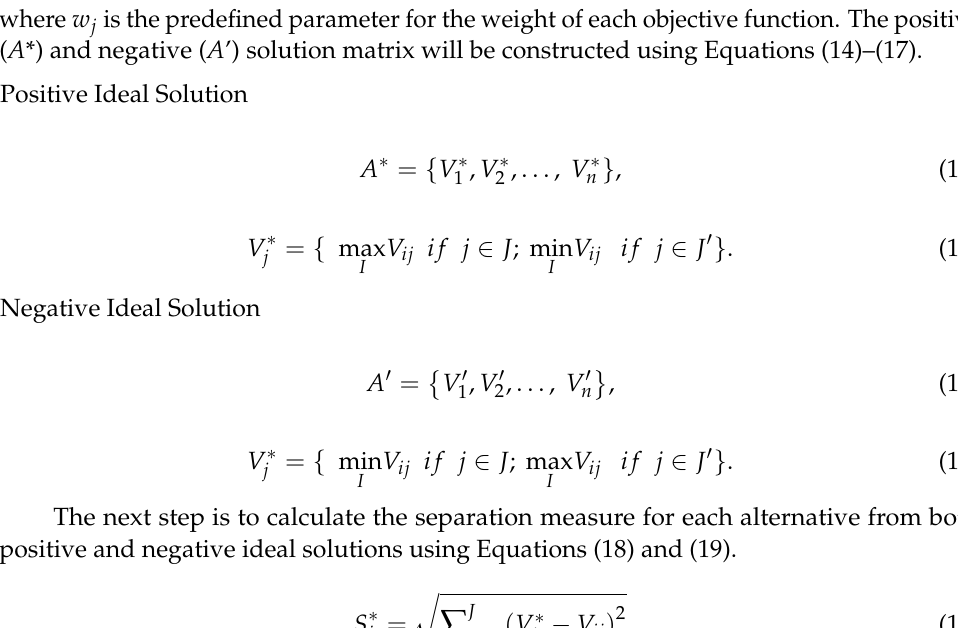
Best Track Transition Method